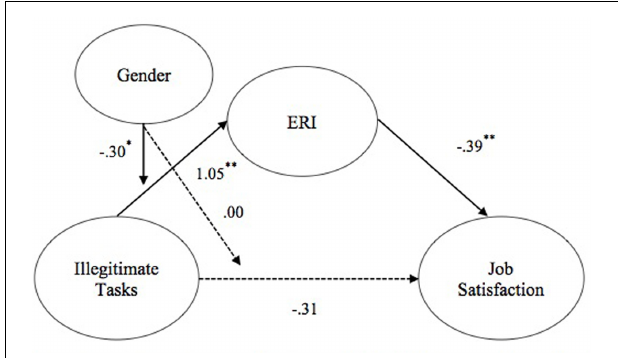
FIGURE 1 | Tested moderated mediation model for illegitimate tasks and job satisfaction. Solid paths represent significant links found. Dashed paths represent links that were hypothesized but non-significant. Parameters represent unstandardized beta coefficients, ∗ p < 0.05, ∗∗ p < 0.01.